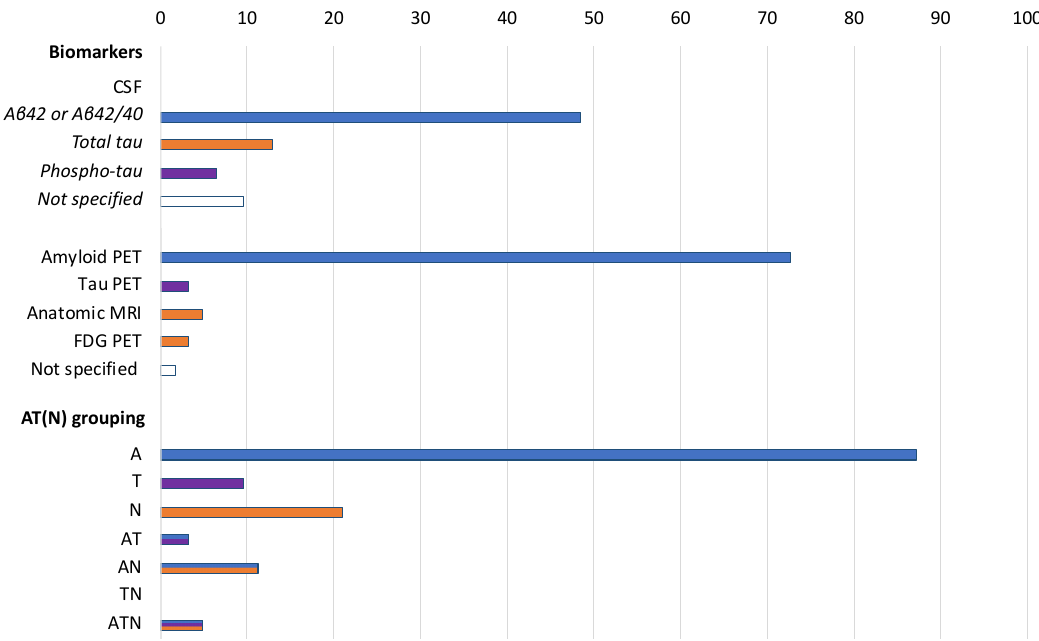
Figure 2. Biomarkers adopted to ascertain eligibility in the selected protocols (n = 62) according to the AT (N) grouping. Data are shown as %. A: aggregated Aβ or associated pathologic state; T: aggregated tau (neurofibrillary tangles) or associated pathologic state; N: neurodegeneration or neuronal injury. Colors refer to AT (N) biomarker grouping: blue: A; purple: T; orange: N. Table 2. CSF cut-o ff s adopted in the six protocols with available